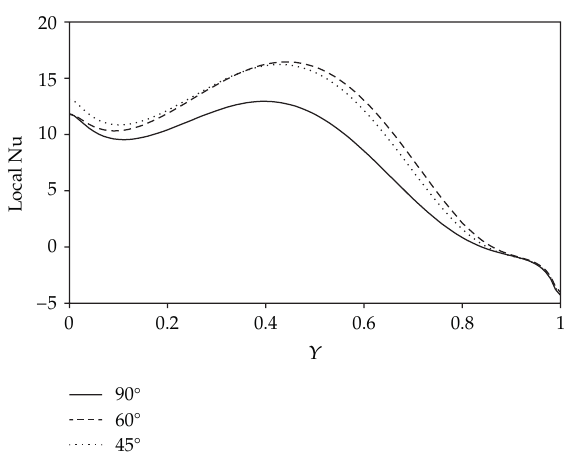
Figure 6: Variation of the local Nusselt number along the hot wall for ε (cid:8) 0 . 5, κ (cid:8) 0 . 75 and Ra (cid:8) 1000. The solid line for the case φ (cid:8) 90 ◦ is the recomputed results of Saeid and Mohamad (cid:3) 8 (cid:4) .